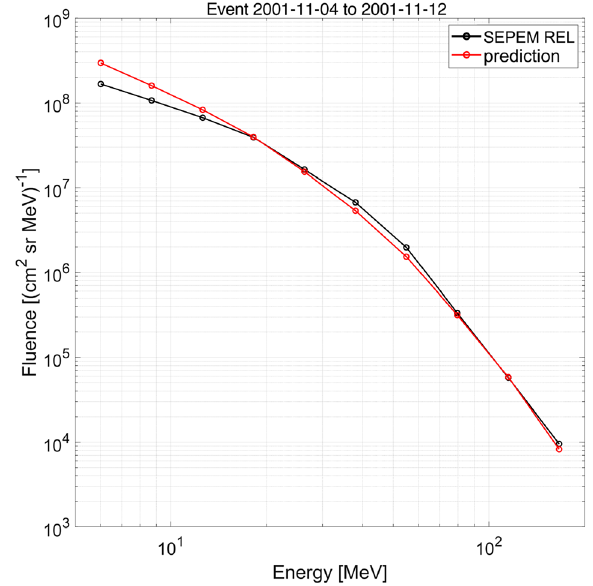
Fig. 14. Final Fluence prediction for the SPE shown in Figure 13 acquired at ~33 h after onset, compared to the actual SPE Fluence of the measured fl ux